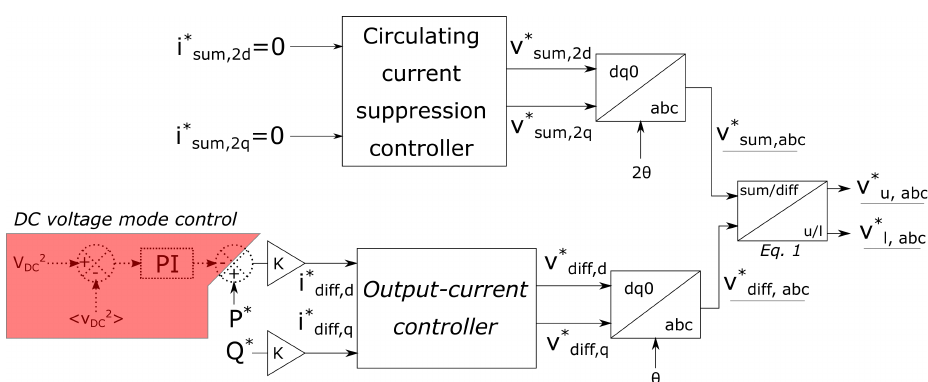
arm-voltages v u , abc ( t ) and v l , abc ( t ) .